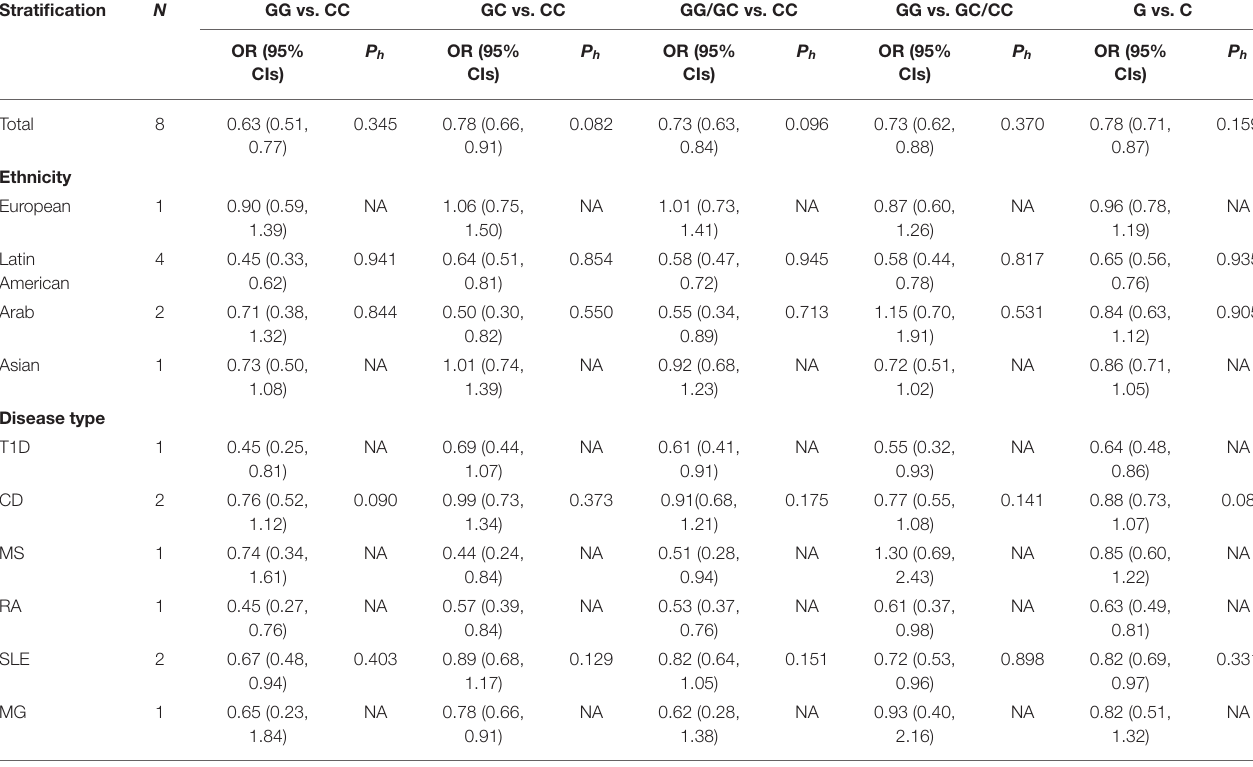
TABLE 4 | Summary of OR and 95% CIs of NLRP3 rs10754558 polymorphism and AIDs susceptibility for various comparisons. Stratification GG vs. GC/CC G vs.